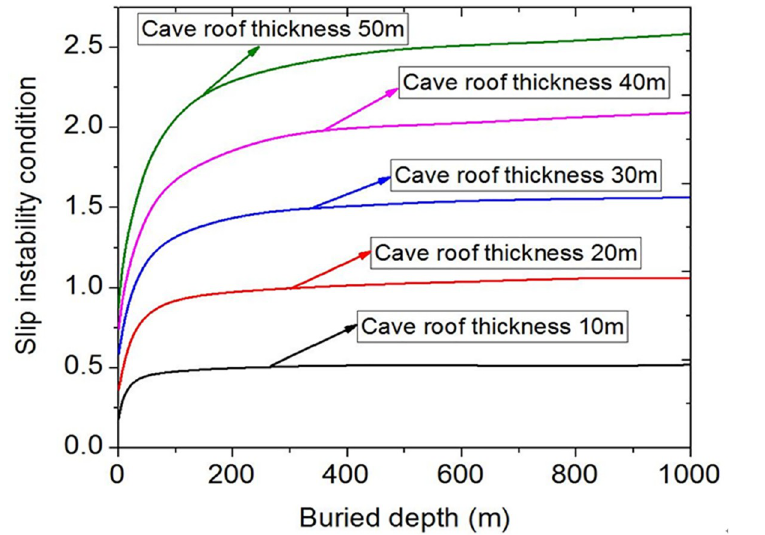
Fig 4. Influence curves of different cave roof